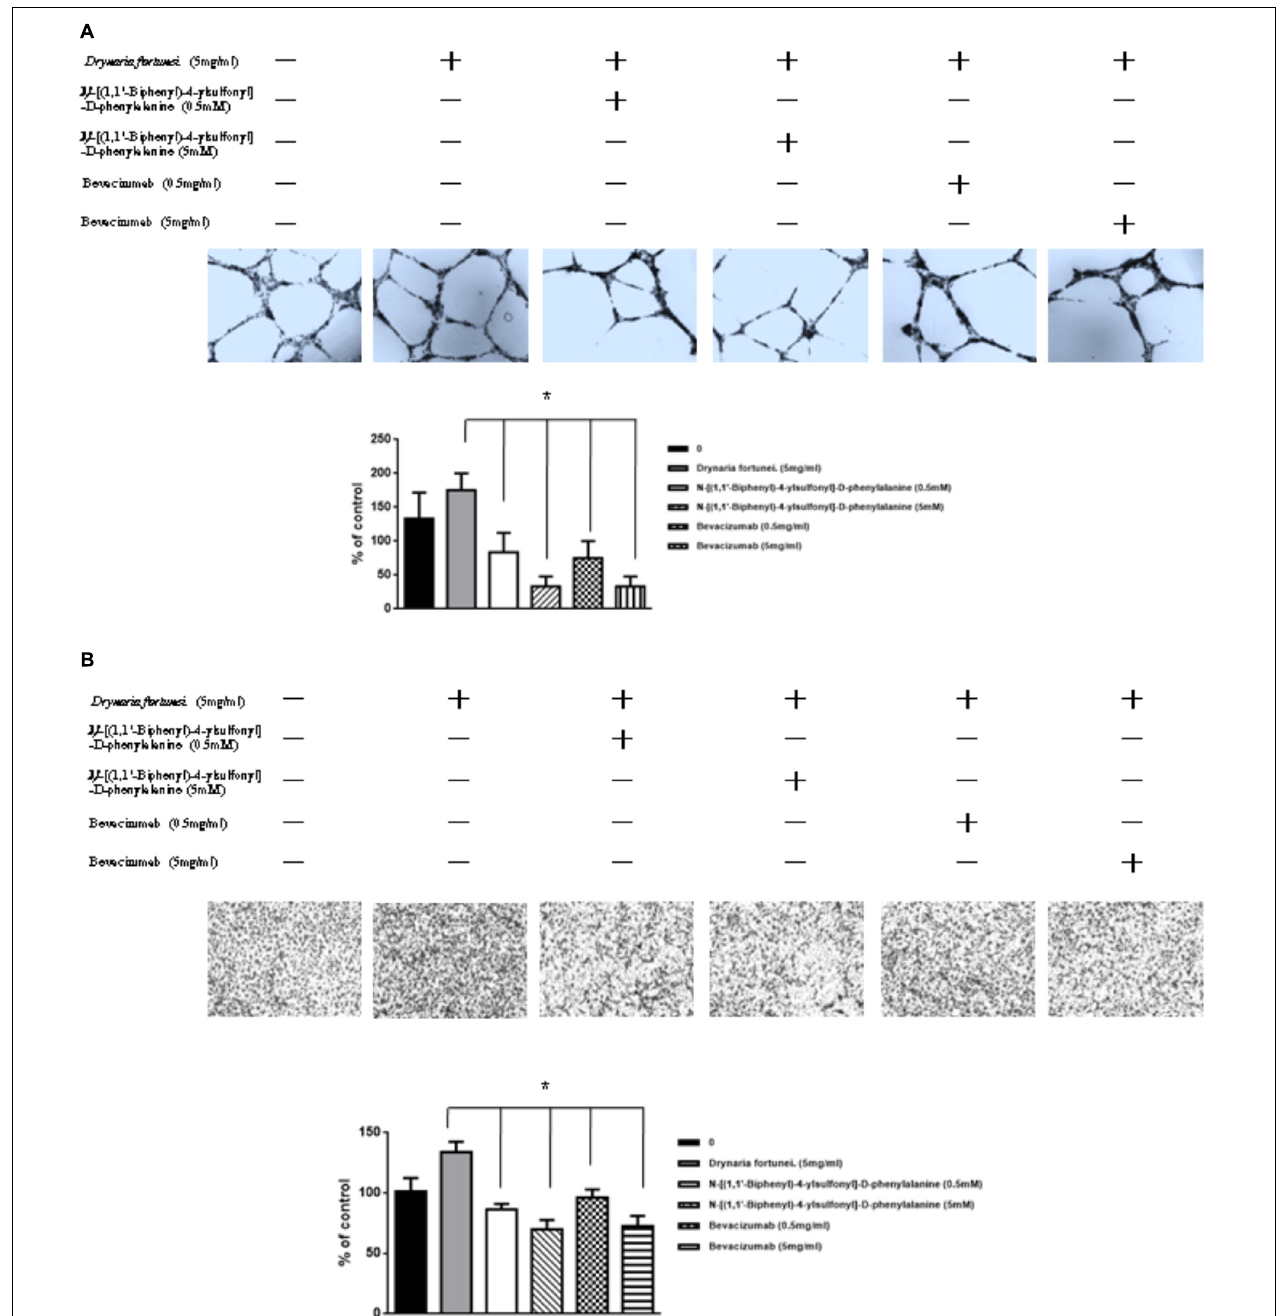
FIGURE 8 | Inhibitors of MMP-2 and VEGF to suppress the angiogenic effects induced by D. fortunei. N -[(1,1’-biphenyl)-4-ylsulfonyl]- D -phenylalanine (MMP-2 inhibitor) and bevacizumab (VEGF inhibitor) blocked D. fortunei -induced transwell tube formation (A) and endothelial cell migration (B) . Data were mean ± SD calculated from three individual experiments. An asterisk demonstrated the significant difference ( ∗ P < 0.05) compared with control.